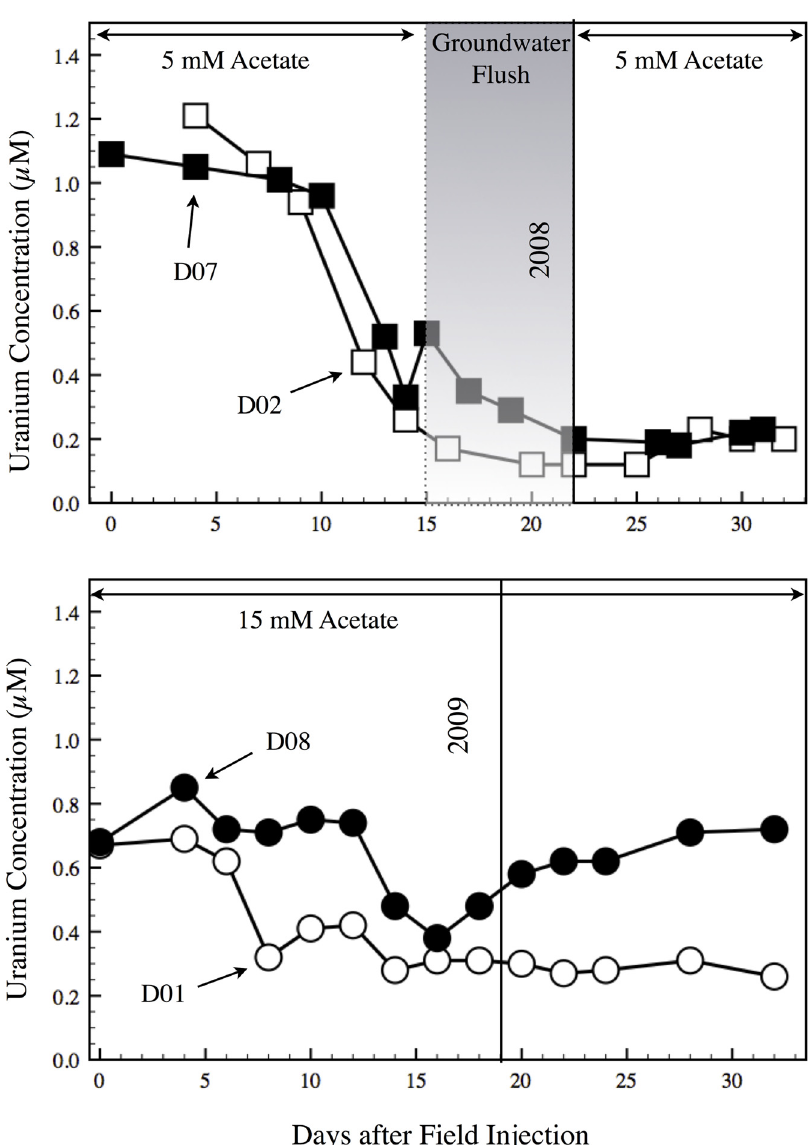
Fig 2. Uranium concentrations from groundwater collected from wells D02 (open square), D07 (closed square); 2008 and D01 (open circle), D08 (closed circle); 2009 Vertical lines indicate the time after field acetate injection when the various wells were sampled for the uranium amendment studies. The groundwater flush in 2008 is indicated in grey